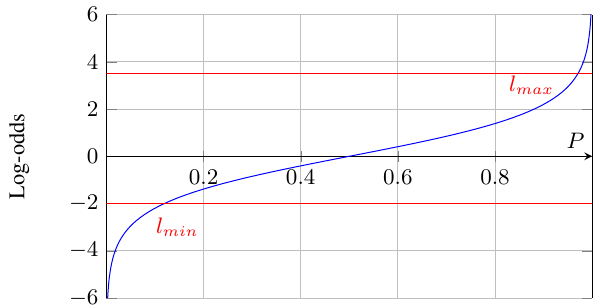
Figure 5. Log-odds of probability in the domain of -6 to 6 Given a laser beam, the occupancy is l free from the laser scanner center and increases to l occ at the location of the point. To sim- plify the log-odds function for a laser beam, the transition from free to occupied is set to be linear, as also the case for the transi- tion to unknown, where l occ is decreased to 0 (Figure 6).